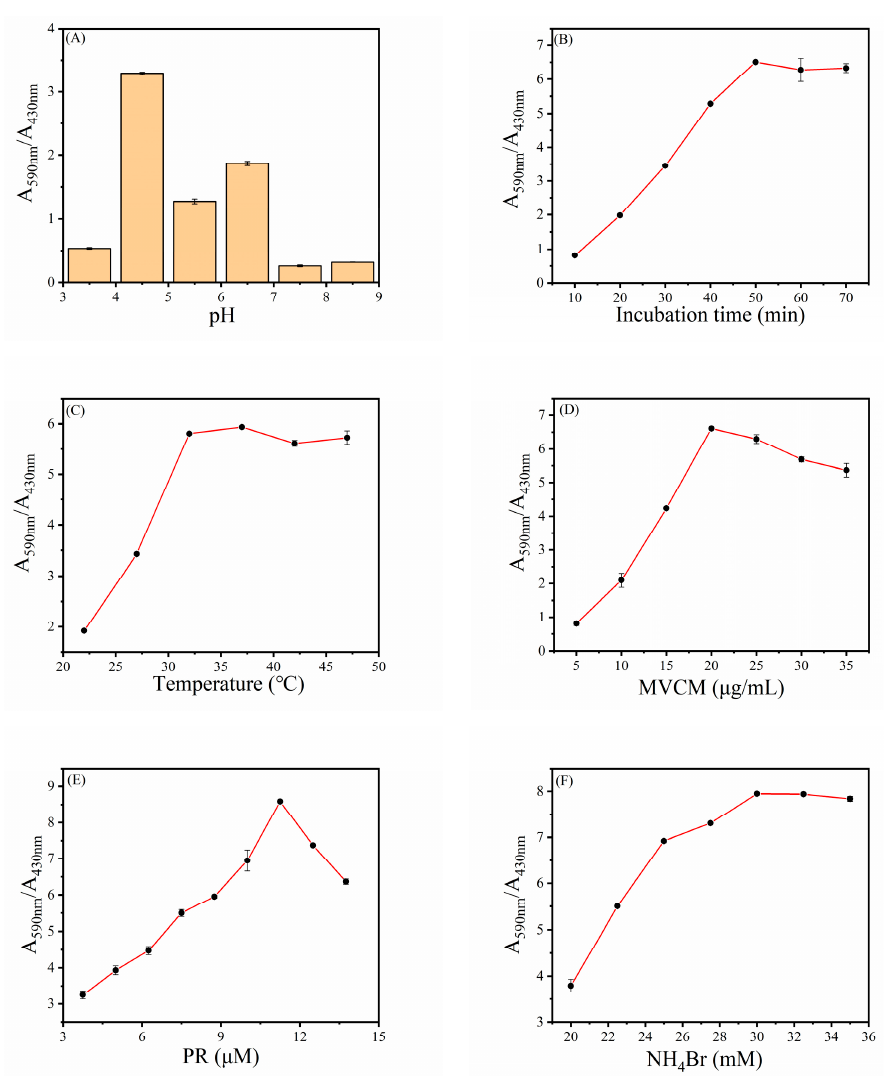
Figure 5. The optimization of ( A ) pH, ( B ) incubation time, ( C ) temperature, and the concentrations of ( D ) MVCM, ( E ) PR, ( F ) NH 4 Br for H 2 O 2 sensing. Error bars represent the standard deviation of three trials.